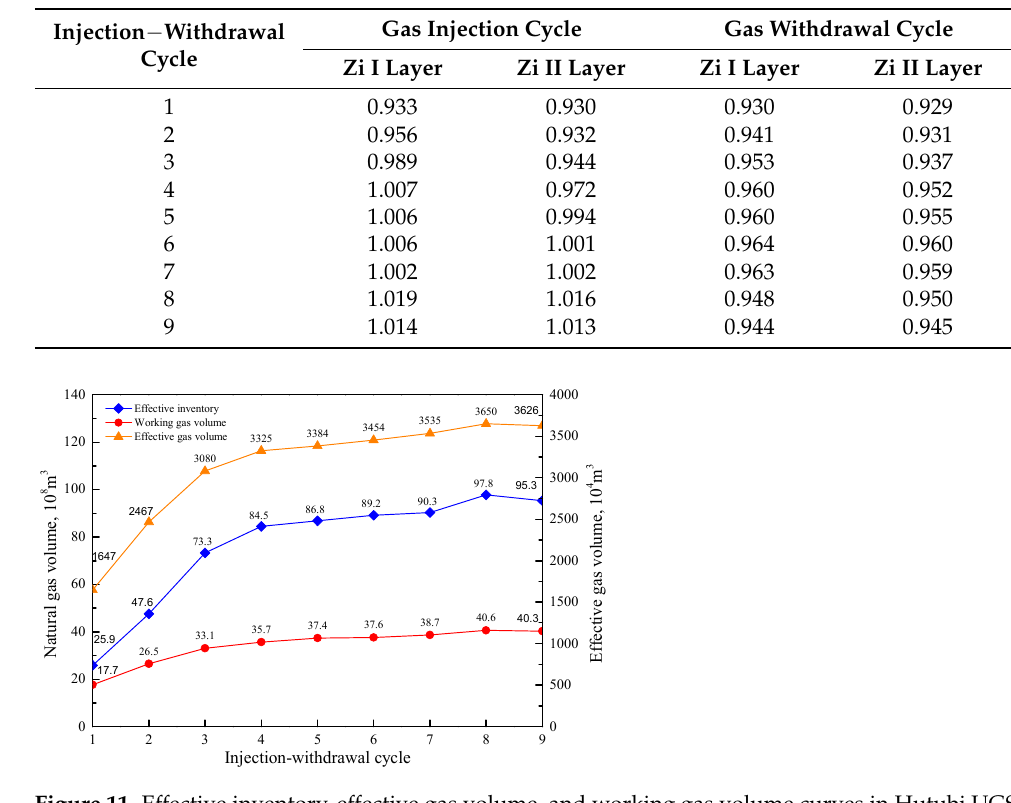
Figure 11. Effective inventory, effective gas volume, and working gas volume curves in Hutubi UGS during nine injection − withdrawal cycles.